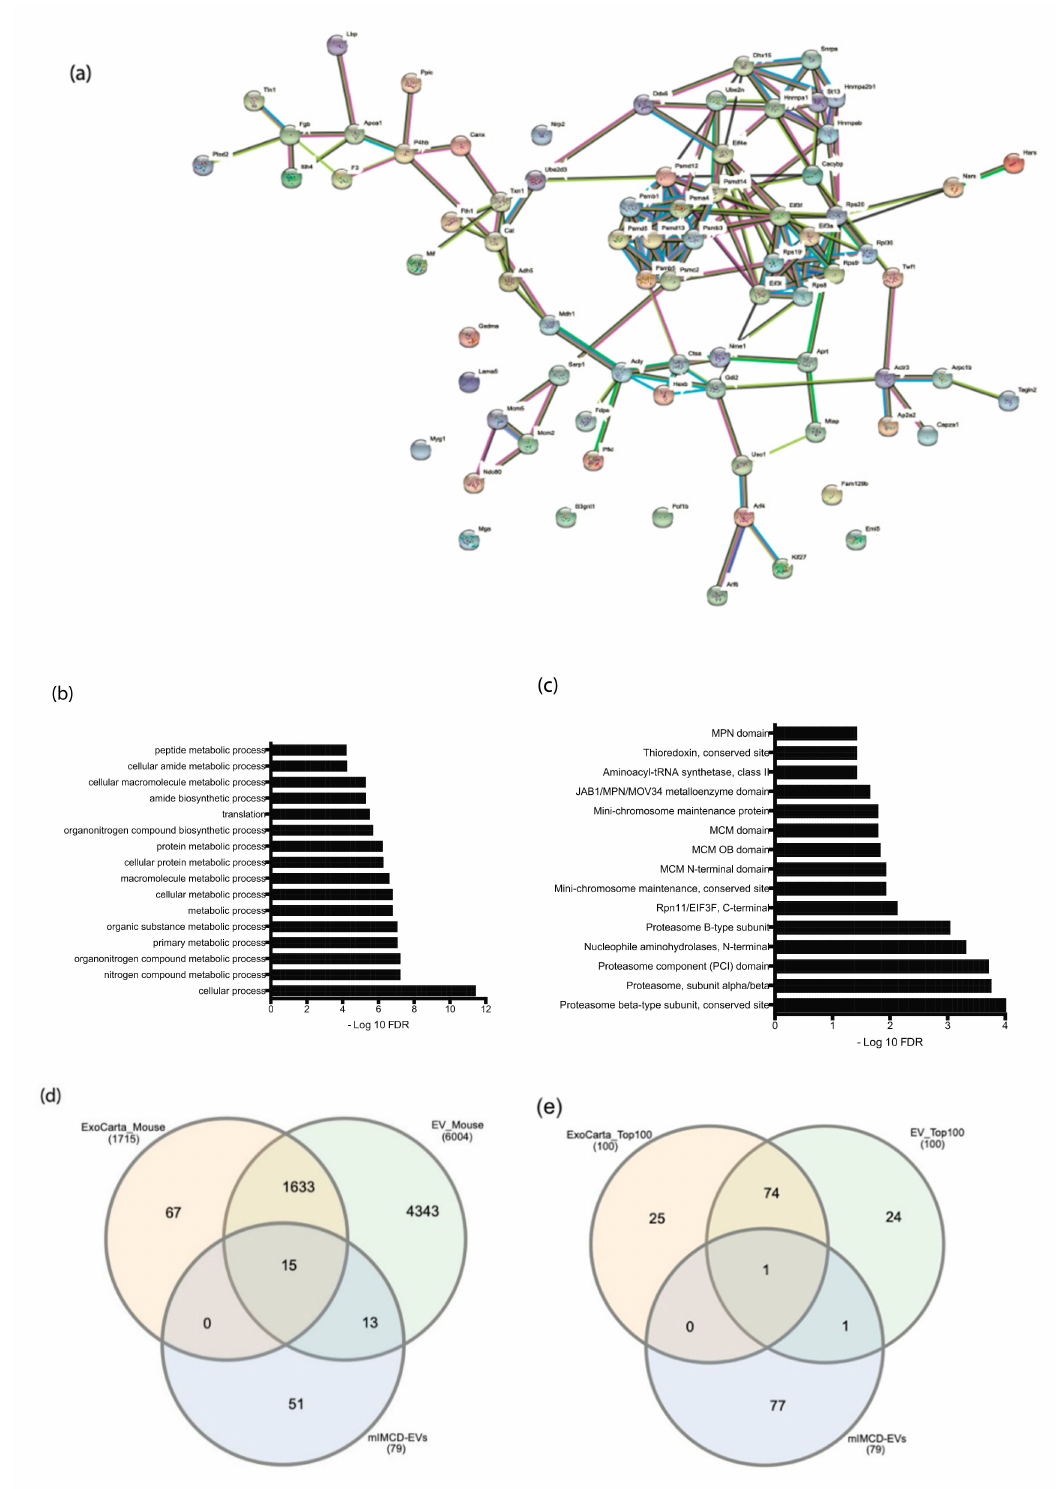
Figure 4. Analysis of mIMCD EV proteins. ( a ) Protein–protein interaction (PPI) network analysis of mIMCD EV proteins. There are significant clusters of interactions for proteolytic degradation, protein synthesis, and cell proliferation (see text). ( b ) Protein process enrichment, scale is − Log 10 (False Discovery Rate). ( c ) Protein identity enrichment, scale is − Log 10 (False Discovery Rate). ( d ) Comparison to available protein databases EVpedia and Vesiclepedia. ( e ) Comparison to the top 100 proteins in EVpedia and